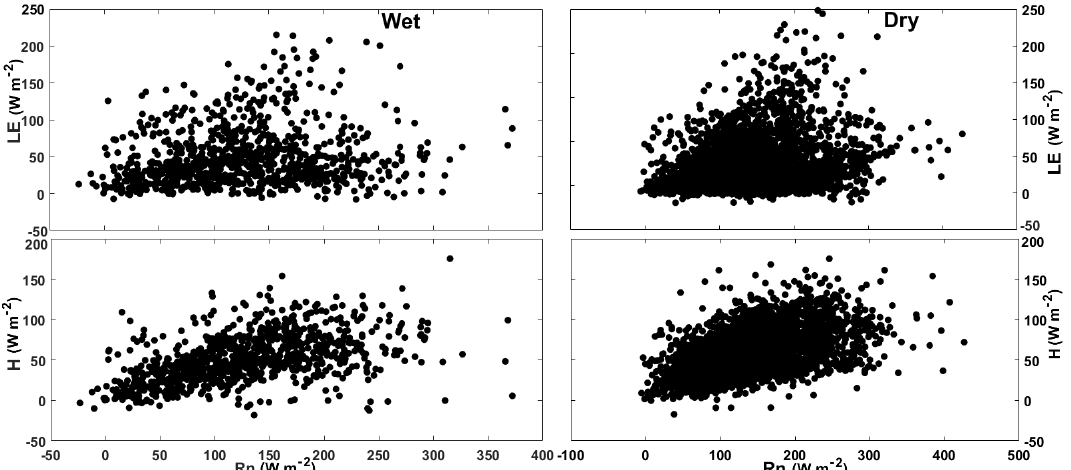
Figure 9. Effects of net radiation on LE and H under wet and dry